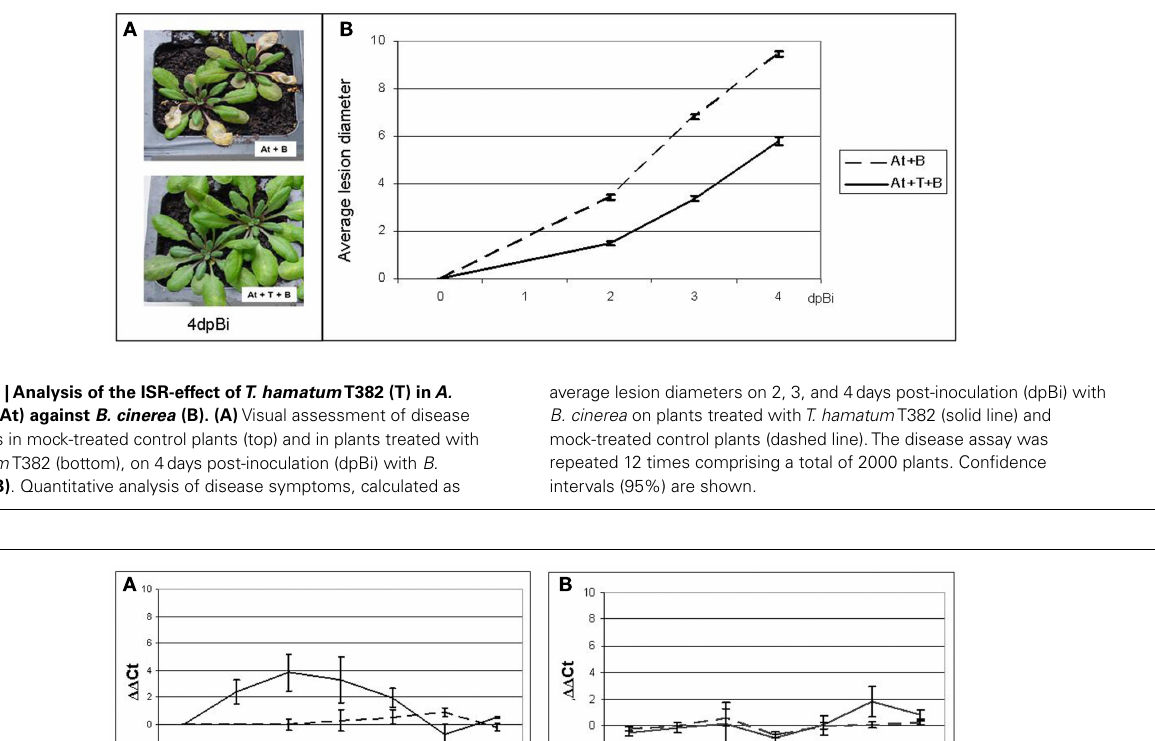
FIGURE 1 |Analysis of the ISR-effect of T. hamatum T382 (T) in A. thaliana (At) against B. cinerea (B). (A) Visual assessment of disease symptoms in mock-treated control plants (top) and in plants treated with T. hamatum T382 (bottom), on 4days post-inoculation (dpBi) with B. cinerea . (B) . Quantitative analysis of disease symptoms, calculated as